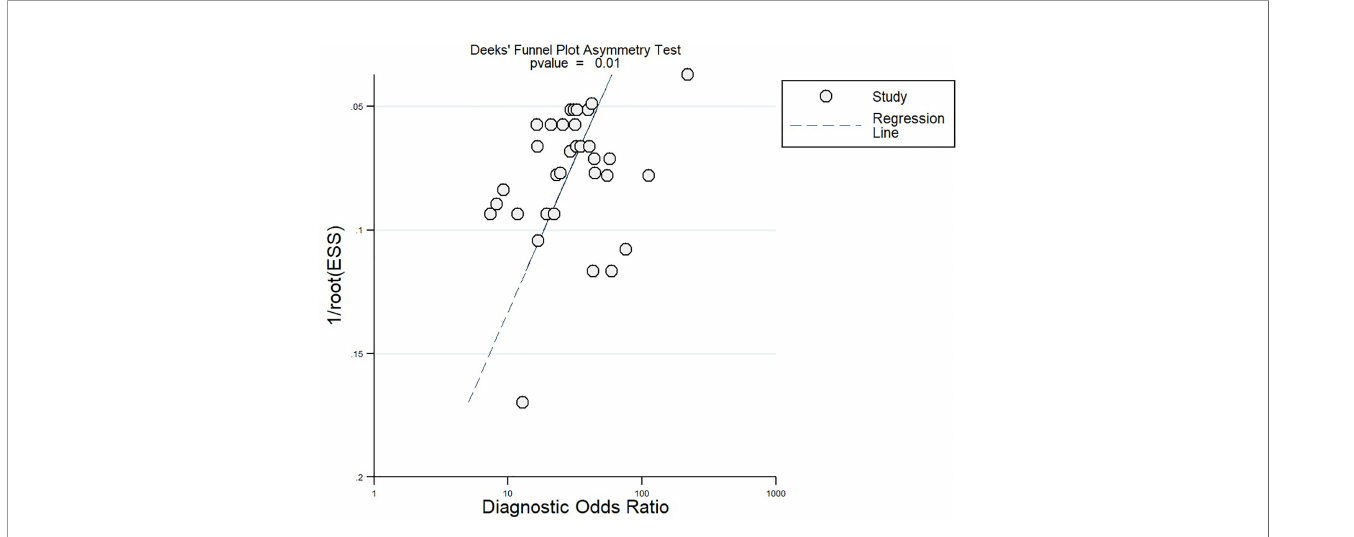
FIGURE 9 | Funnel plot for publication